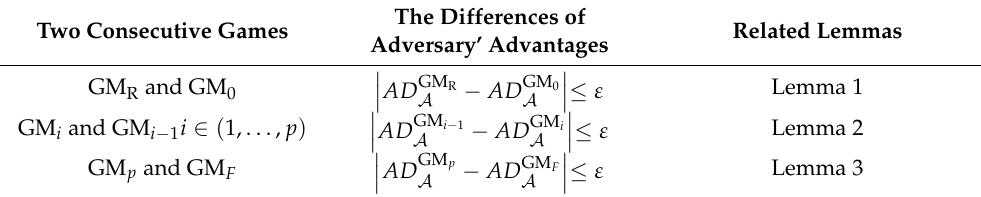
Table 1. The differences between the adversary’ advantages in two consecutive games. Two Consecutive Games GM R and GM 0